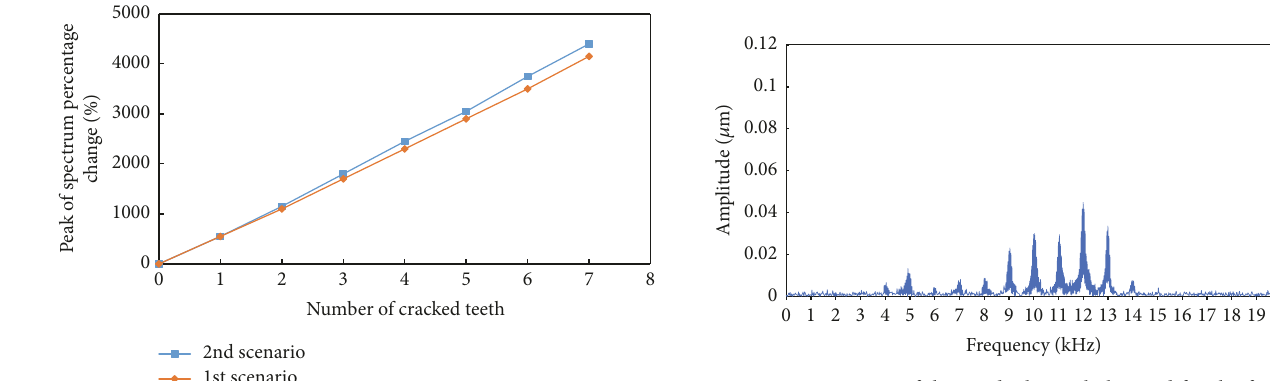
Figure 46: Spectrum of the residual signal obtained for the fourth scenario (Case (7) with consecutive cracked